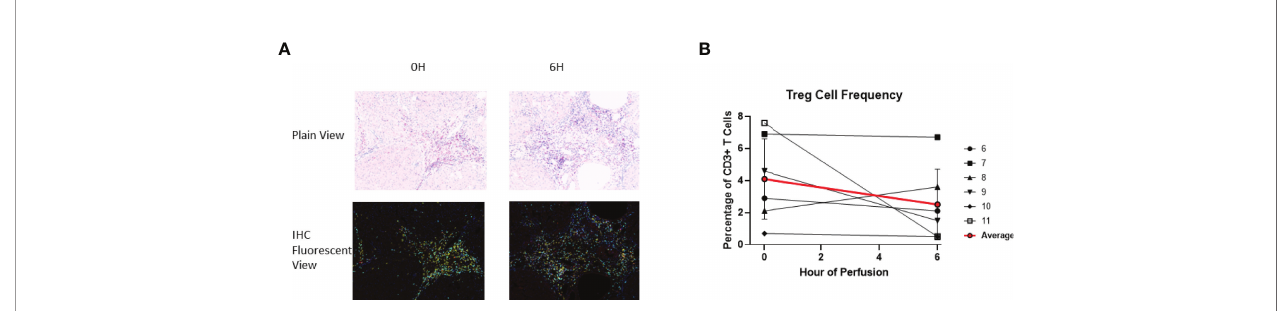
FIGURE 10 | Identi fi cation of Treg using IHC (DAPI+CD3+CD4+FoxP3+). (A) Representative Slides (Liver 6) from before (0 th hour) and following perfusion (6 th hour). DAPI (Blue), CD3 (Cyan), CD4 (Yellow), FoxP3 (Red). (B) Treg cell frequency out of total CD3+ T cells both before and following